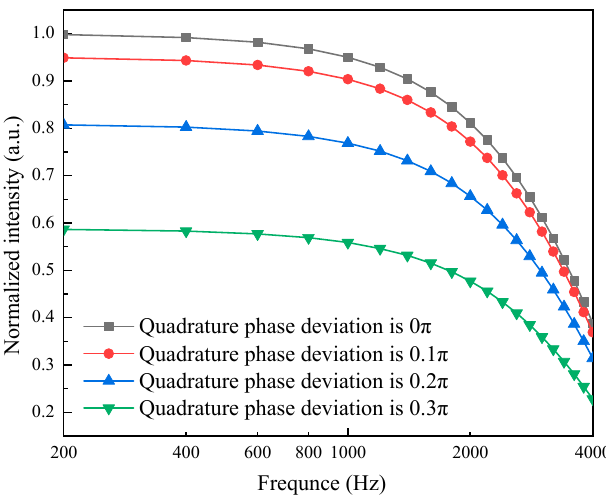
Figure 5. Frequency response curves for different quadrature phase deviations.